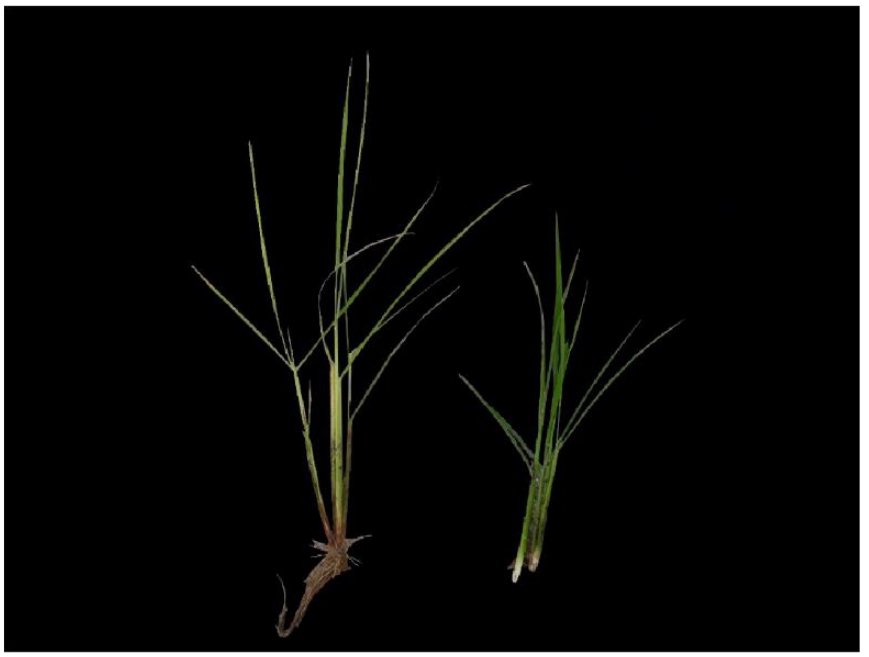
Figure 1. Rice infected with Bakanae disease (left) and normal rice (right).